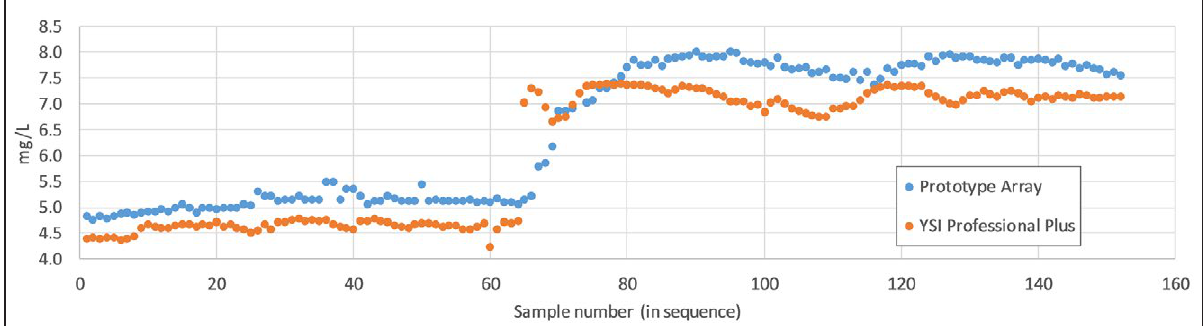
Figure 6: Comparison of dissolved oxygen readings from prototype array and YSI Professional Plus along stream